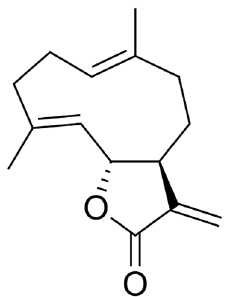
Figure 1. Chemical structure of costunolide.